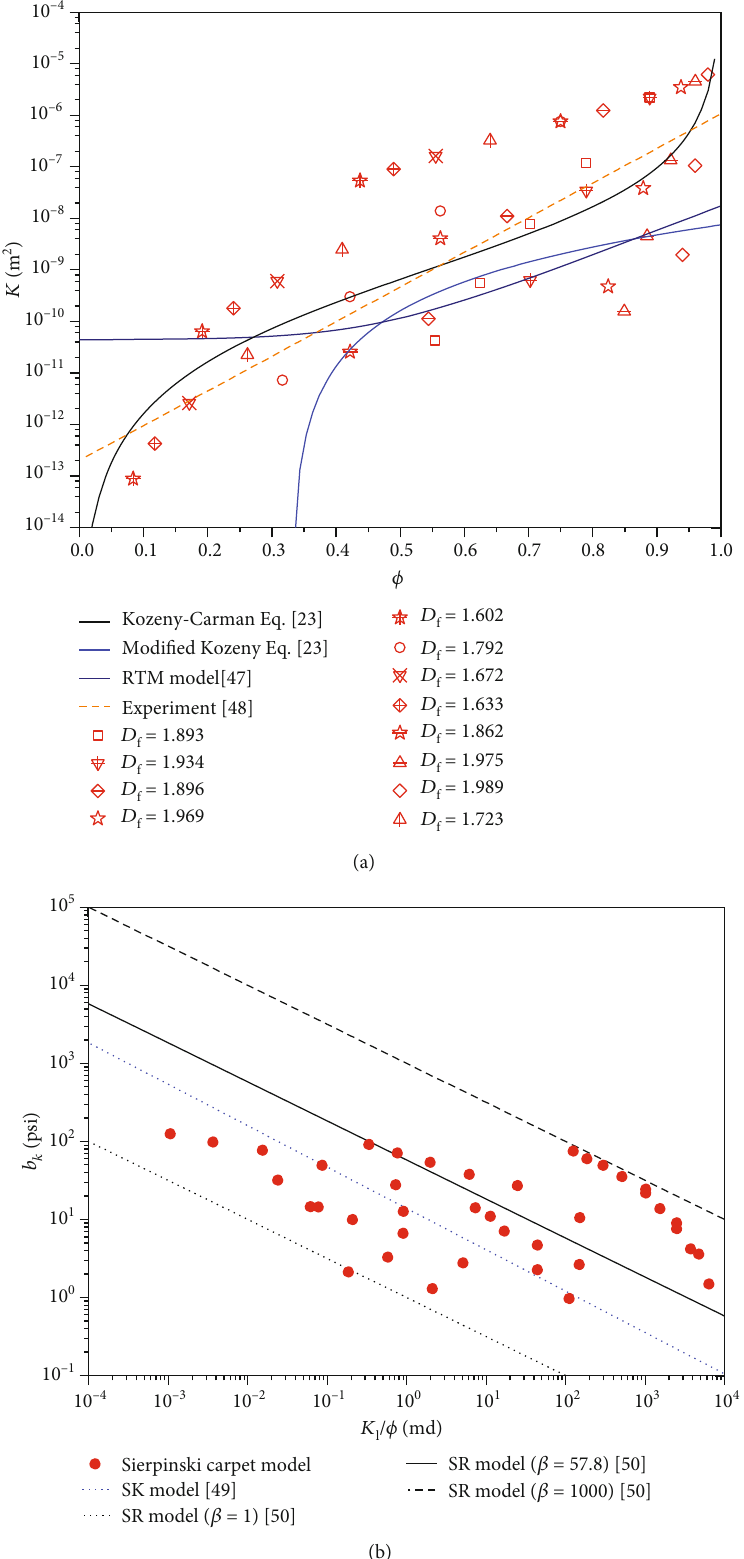
Figure 3: A comparison of present numerical results with theoretical models and experimental data: (a) permeability without slippage e ff ect and (b) gas slippage factor vs. absolute